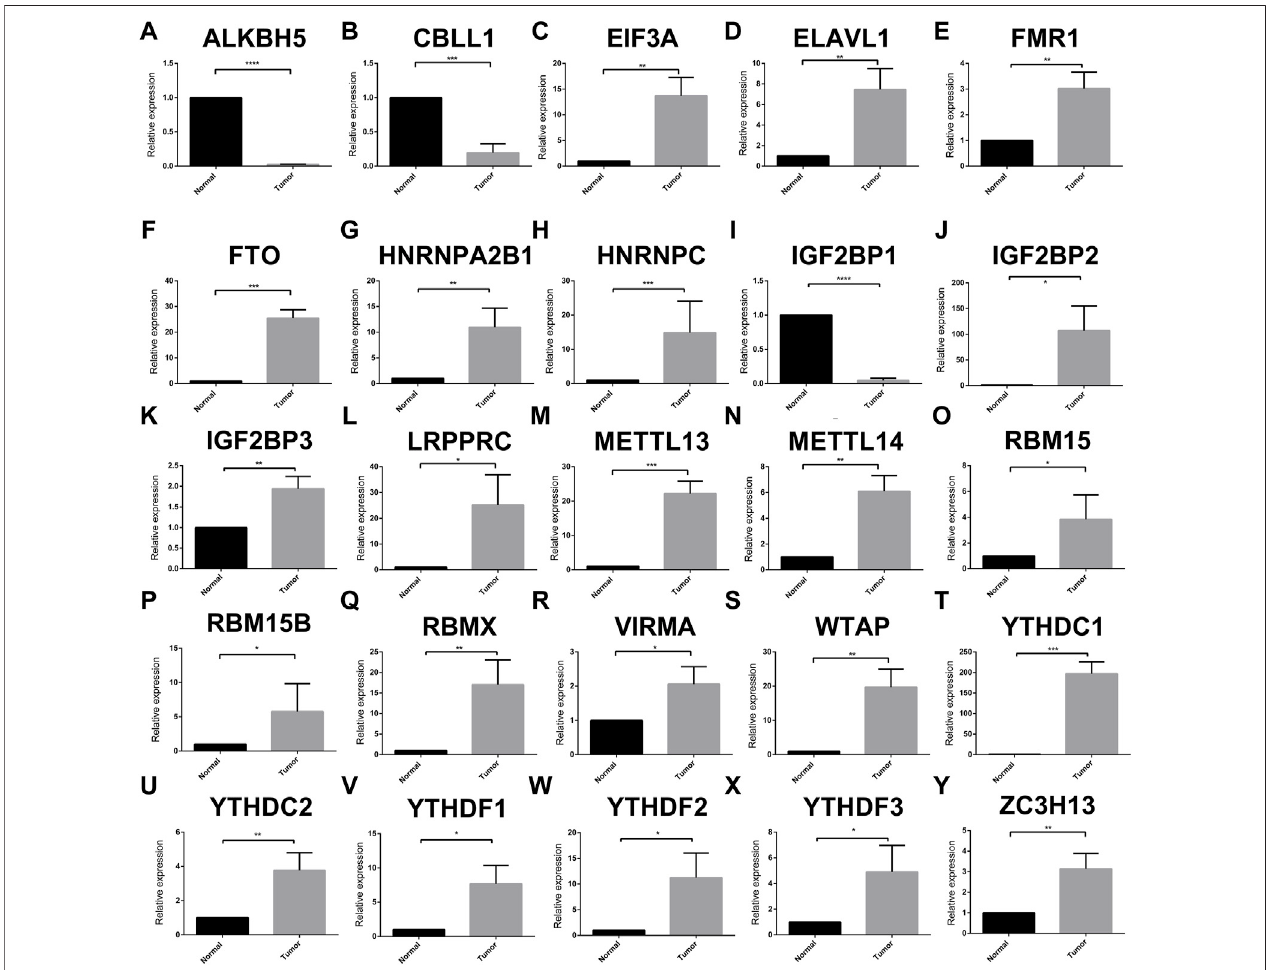
FIGURE 2 | Expression of 25 m6A regulators between STS and normal adjacent tissue. (A – Y) Expression of different m6A regulators between normal adjacent tissue and STS samples. p < 0.05*, p < 0.01**, p < 0.001***, and p = 0****.